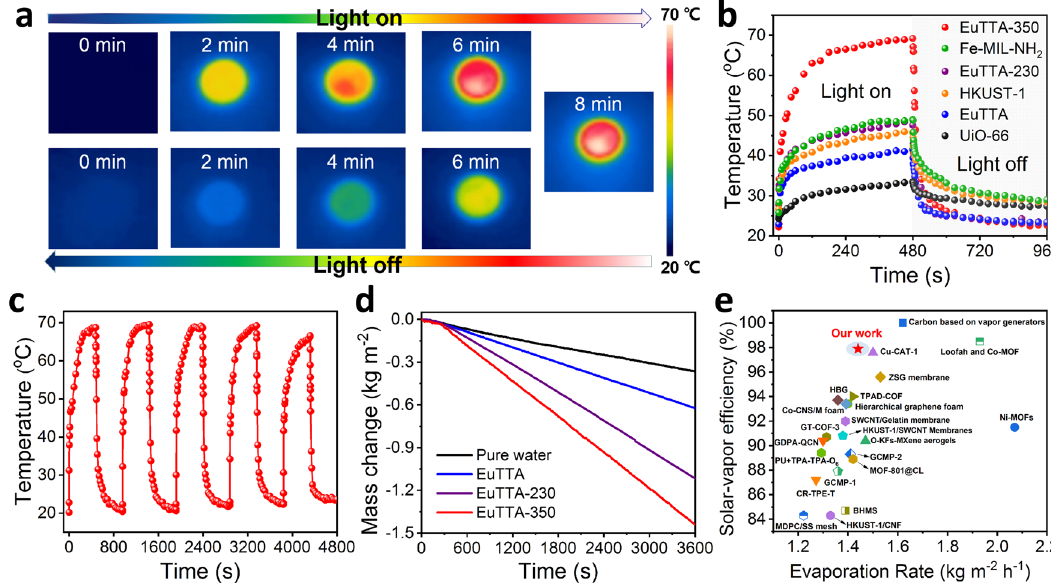
Fig. 5 | Characterization of photothermal conversion and water evaporation properties.a IRthermalimagesofEuTTA-350powder(50mg)underaXenonlamp (1kWm − 2 ) and then with the Xenon lamp turned off. b Photothermal conversion behavior of EuTTA, EuTTA-230, EuTTA-350, Fe-MIL-NH 2 , HKUST − 1, and UiO-66 powder samples under 1-sun irradiation within 480s. c